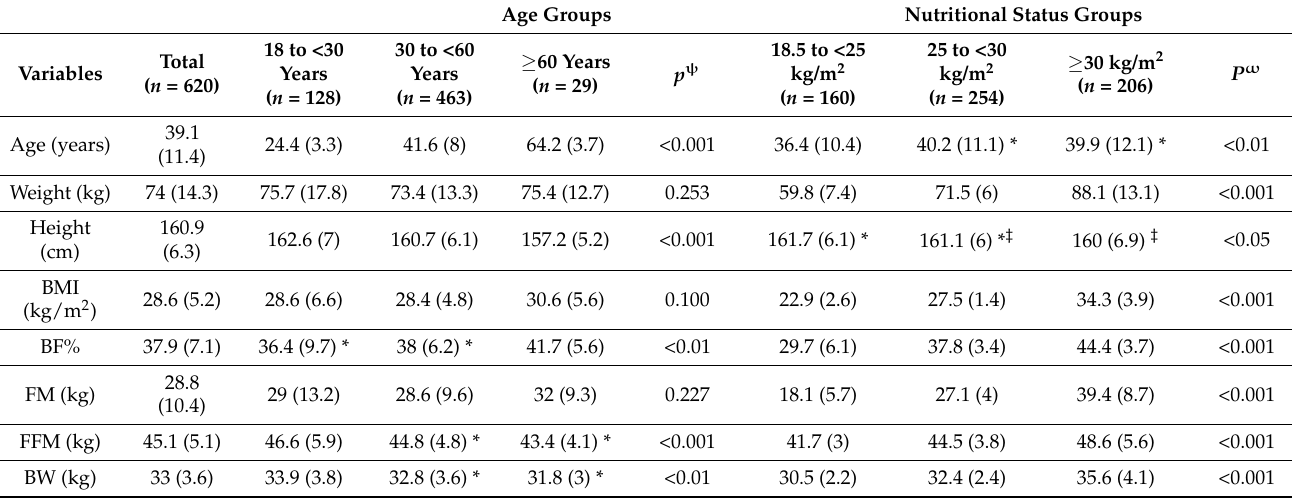
Table 2. Characteristics of participants according to age groups and nutritional status. Age